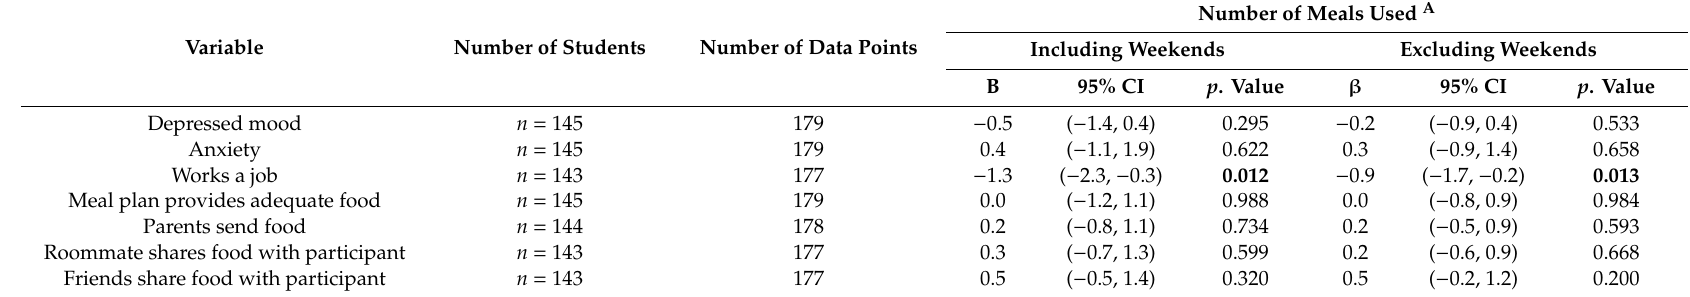
Table 6. Results of the linear generalized estimating equation (GEE) testing what factors are related to the number of meals students used A on the 180 meals / semester B meal